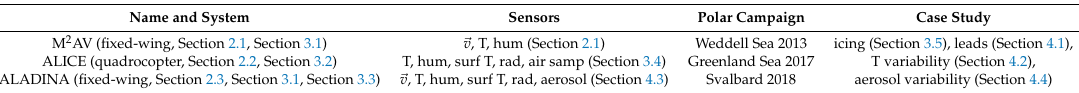
Table 1. Overview of the systems, instrumentation and measurement campaigns presented in the article. (cid:126) v represents the wind vector, “T” stands for air temperature, “hum” humidity, “rad” radiation, “air samp” air sampling and “surf T” is surface